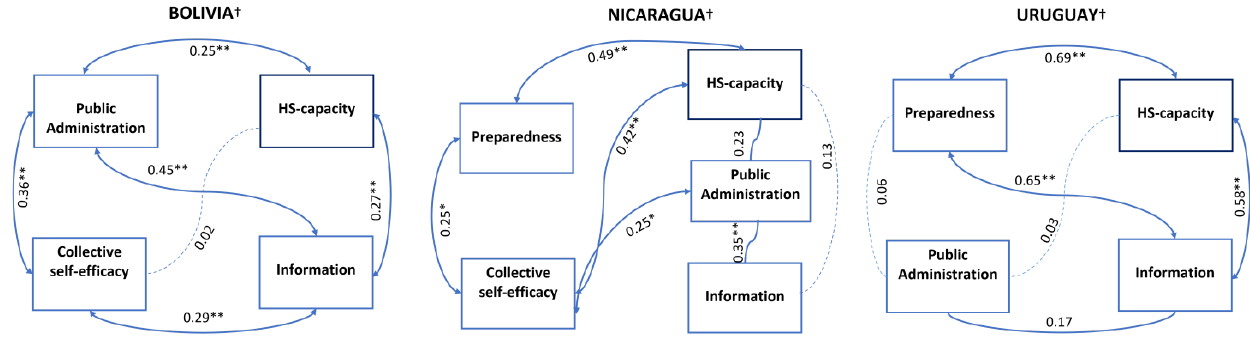
Figure 4. Factor correlations for each country. This figure contains Pearson correlations (2-tailed) between factors per country. Solid lines represent significant and dotted lines represent non-significant correlations. † p < 0, * p < 0.05, ** p < 0.01.